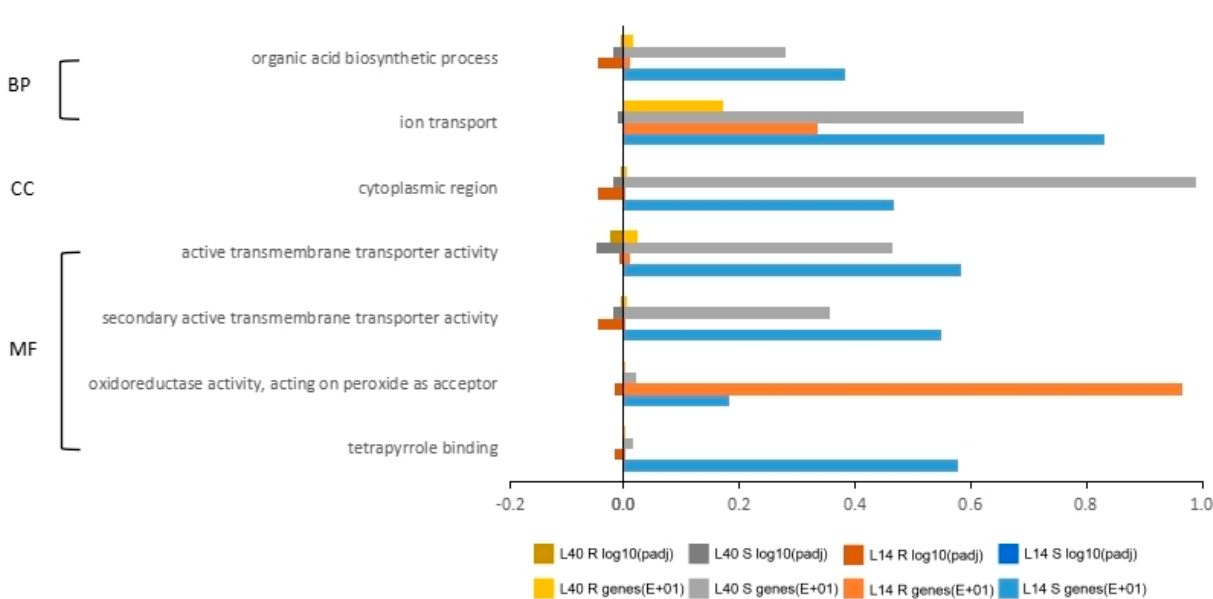
Figure 7. Gene ontology of DEGs from LN treatments in L14 and L40.